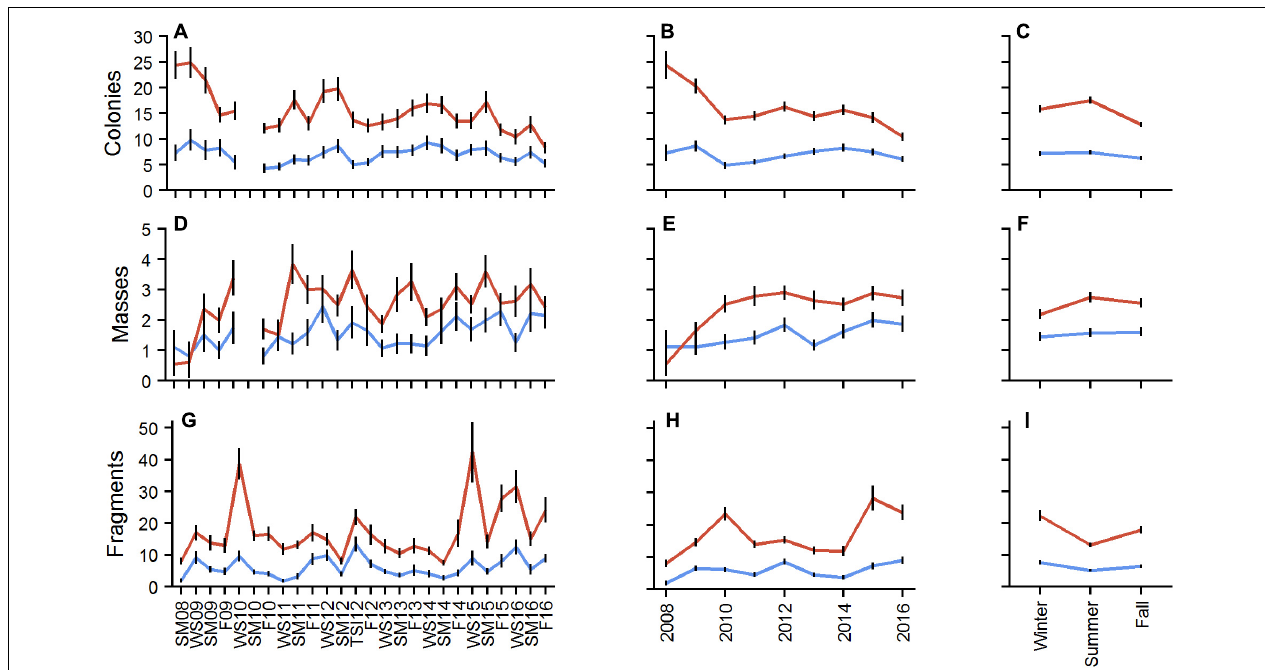
FIGURE 4 | Mean number of colonies (A–C) , masses (D–F) , and fragments (G–I) by plot for BCA (blue) and Scooter (red) by monitoring event (A,D,G) , year (B,E,H) , and season (C,F,I) . Error bars indicate ± 1 SE.